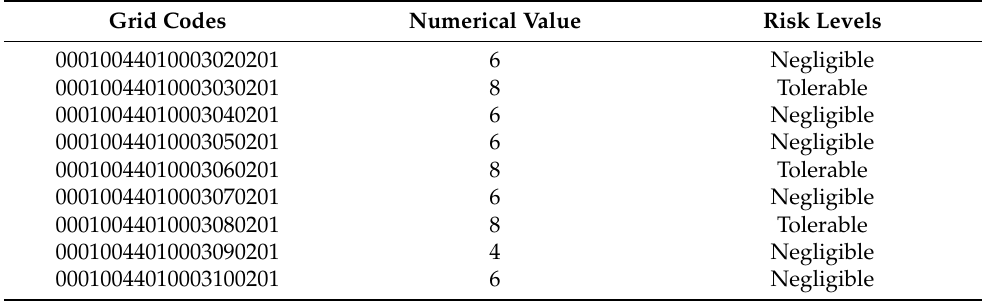
Table 13. Risk magnitude of “the assistant watchman did not appear as required”